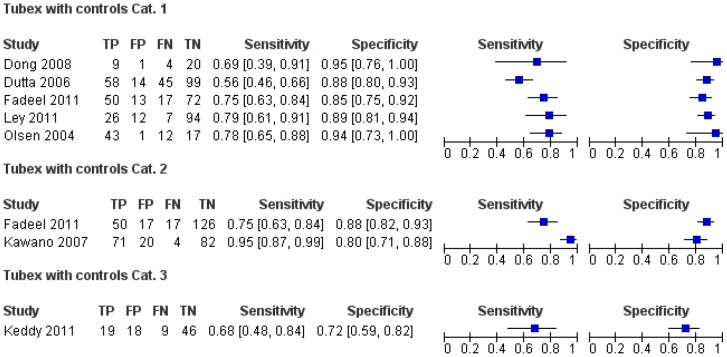
Forest Plot for Tubex TF with different control groups.